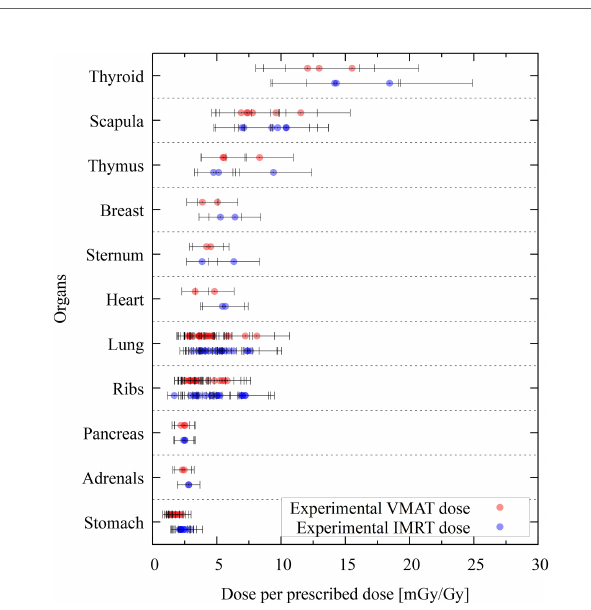
FIGURE 6 | Experimental thermoluminescent dosimeter (TLD) dose values grouped per organ. The dose is given in dose per prescribed dose (mGy/Gy). Absorbed volumetric modulated arc therapy doses are shown with red dots, and intensity-modulated radiotherapy doses are given with blue dots. Statistical uncertainties ( k = 2) are given for each TLD position.